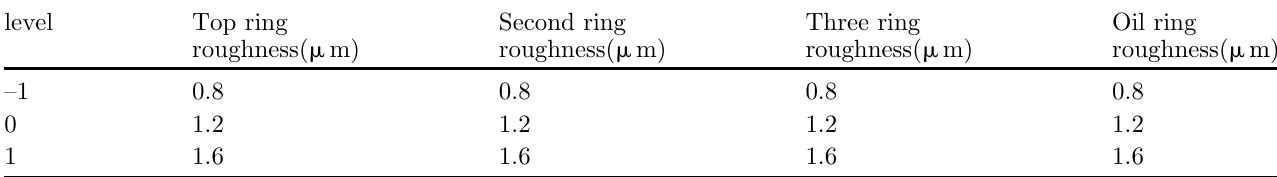
Table 4. Box-Behnken design factors and